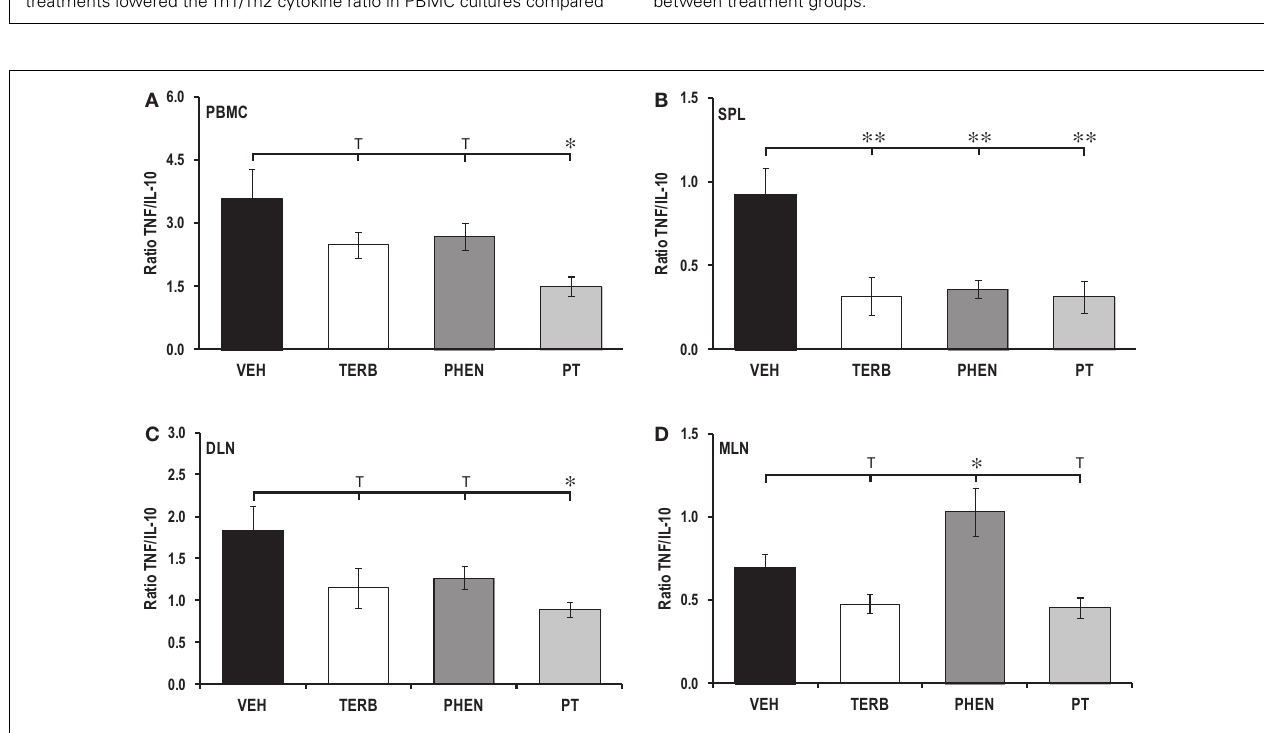
withVEH treatment. PTTh1/Th2 cytokine ratios were higher than with PHEN treatment. N = 8. *** p < 0.001. (B) Spleen:Th1/Th2 cytokine ratios did not differ between AA rats treated with any of the drug treatments compared withVEH treatment. (C) DLN, similar ratios were found in all groups. (D) MLN, no differences inTh1/Th2 cytokine ratios were found between treatment groups.